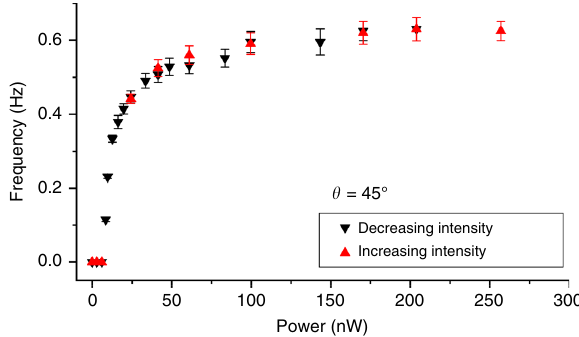
Fig. 4 Comparison of rotation frequency dependences on optical power obtained while decreasing and increasing intensity. Rotation frequency was measured fi rst on a platelet spinning under blue excitation light of decreasing intensity and then, using the same particle, upon increasing intensity. These data were obtained for P e at θ = 45° with respect to the far- fi eld director n 0 . Data points are mean ±